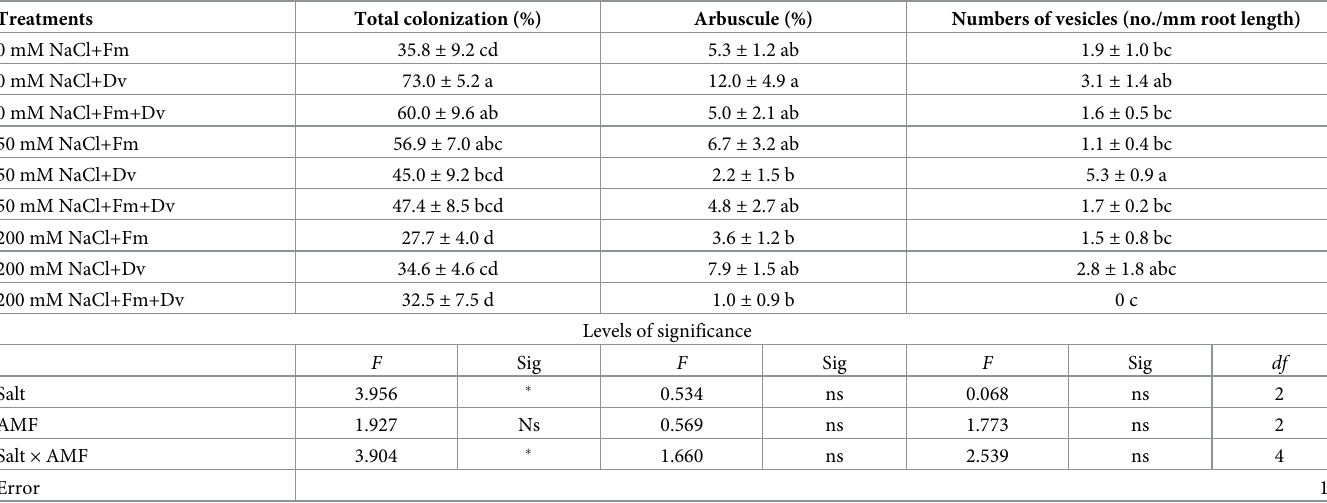
Data in the table are expressed as the mean ± SE. Values in columns followed by the same letter do not differ significantly at P < 0.05 by LSD multiple range test. Fm, Dv and Fm+Dv represent inoculation with Funneliformis mosseae , Diversispora versiformis and the combination of F . mosseae and D . versiformis , respectively; ns , not significant at P > 0.05; (cid:3)